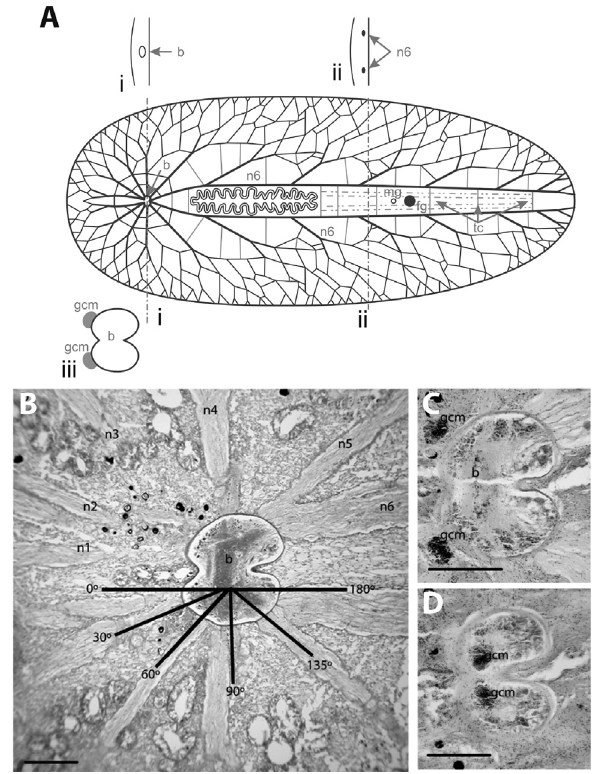
Figure 1 - Polyclad nervous system organization: Category I. A. Sche- matic representation includes cross sections at the level of the brain (i) and at the level of the n6 nerve pair (ii); detail of the brain is shown below (iii) B. Longitudinal section through the anterior region of Styloplanocera fasciata showing the distribution of the ventral nerve cords . Scale bar 250 (cid:2) m. C. Section through the ventral region of the S. fasciata brain, showing the external globuli cell masses. Scale bar 250 (cid:2) m. D. Section through the dorsal region of the S. fasciata brain, showing the internal globuli cell masses. Scale bar 250 (cid:2) m. b brain, fg female gonopore, gcm globuli cell masses, mg male gonopore, n nerve cords, n6 major nerve cords, tc trans- verse